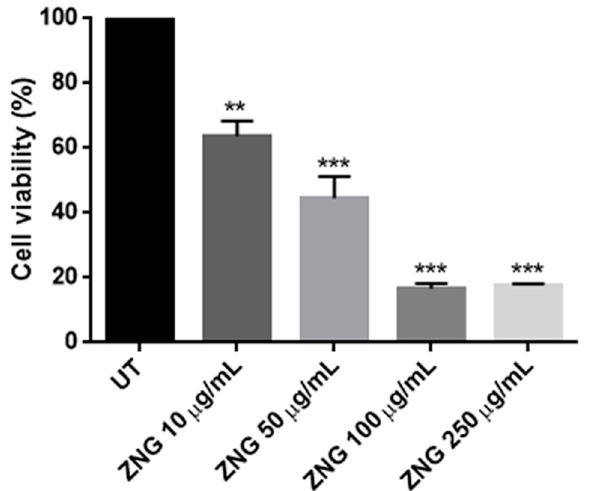
Figure 2. Analysis of Colony Forming Units (CFU) counting for Candida albicans cells untreated (UT) or treated with ZNG nanomaterials at different concentrations. Statistically significant differences with the untreated group were calculated by using one-way ANOVA with Bonferroni’s post-test. (** p < 0.01, *** p < 0.001).